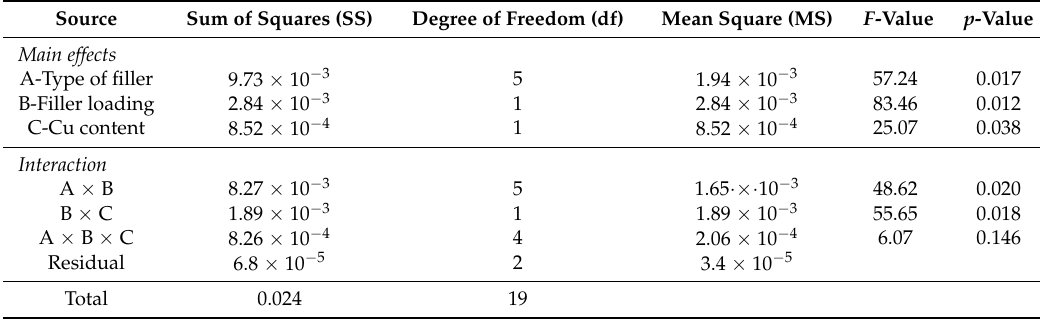
Table 4. ANOVA for parameter thickness (mm).